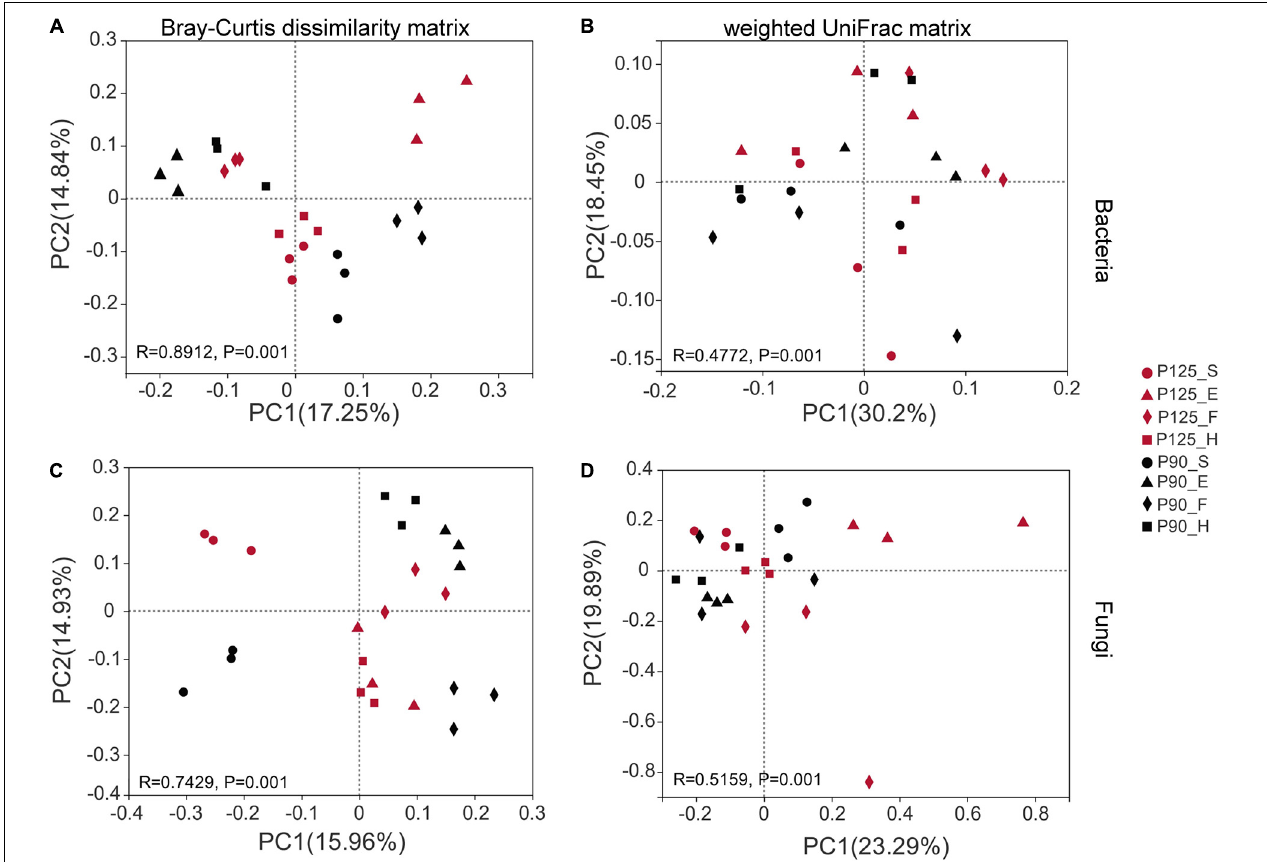
FIGURE 2 | Beta diversity of the microbial community was analyzed using the principal coordinate analysis (PCoA) diagram based on the Bray–Curtis dissimilarity matrix and weighted UniFrac matrix. (A,B) Bacterial community. (C,D) Fungal community. The percentage of the two main axes represents the explanatory value of the difference in the sample composition. Points of different colors and shapes represent different treatments (P125, with a rate of 125 kg P 2 O 5 ha − 1 ; P90, with a rate of 90 kg P 2 O 5 ha − 1 ) and growth stages [seedling stage ( S ), ear stage ( E ), flowering stage ( F ), and harvest stage ( H )], respectively. The distance between two sample points indicates the similarity of the species composition of the two samples ( p =